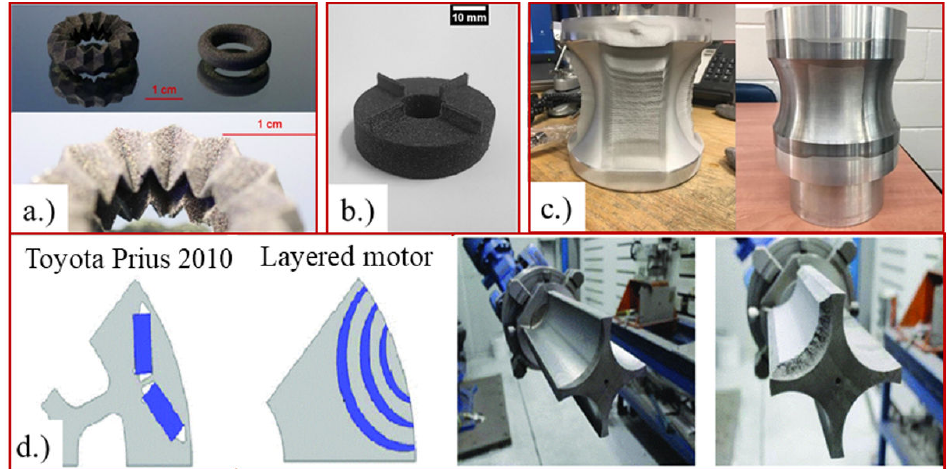
Figure 4. Examples of AM-built PMs ( a ) complex shaped PM realization [51] ( b ) NdFeB magnet produced by Selective Lase Sintering (SLS) [52] ( c ) bi-material hollow shape for electrical engines, with base material as iron and having NdFeB-Al composite at 0 ◦ ,90 ◦ ,180 ◦ ,270 ◦ [53] ( d ) Enhanced interior PM motor for hybrid electric vehicle, with layered PM (left) design concept (right) fabrication process utilizing cold-spray AM